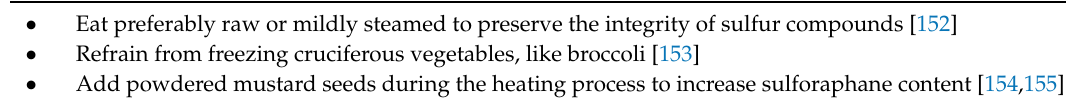
Table 3. Preparation tips for sulfur-rich